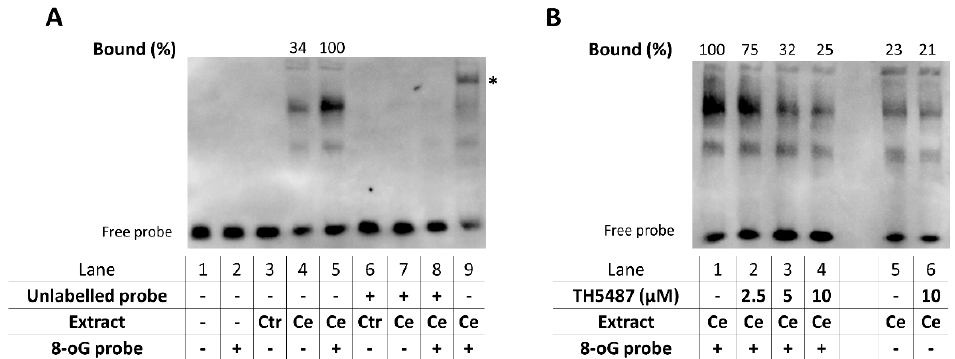
Figure 7. OGG1 inhibition reduces the amount of active NF- κ B in AP and decreases NF- κ B-binding to 8-oxoG-containing response elements. ( A ) Pancreatic nuclear extracts were prepared from mice treated with saline (Ctr) or cerulein (Ce). EMSA was performed by incubating the extracts with native or 8-oxoG modified NF κ B-response element containing oligonucleotide probes. A mobility shift of the native probe confirmed that the Ce nuclear extracts contained active NF- κ B (lane 4), whereas the Ctr extract caused no shift (lane 3). Nearly 3-fold increase was detected in NF- κ B binding when a guanine by the response element in the probe was replaced with 8-oxoG (lane 5 vs. 4). The assay specificity was confirmed by competing off binding with an excess of unlabeled probe (lane 7–8) and by supershifting the probe with an anti-p65 antibody added to the Ce extract prior to the EMSA (lane 9, asterisk). ( B ) TH5487 when added to the Ce extract before the DNA, decreased NF- κ B binding to 8-oxoG containing probes in a dose-dependent manner (lanes 1–4). TH5487 markedly decreased NF- κ B DNA occupancy in the presence of 8-oxoG next to the response element (lane 4) but had no effect in the absence of 8-oxoG (lane 6). Data are representative of three experiments. Binding occupancies were calculated from band intensities using the Image J software. Relative band intensities were compared to the Ce extract incubated with the 8-oxoG probe, which was taken as 100% (lane 5 and lane 1 in panels A and B,